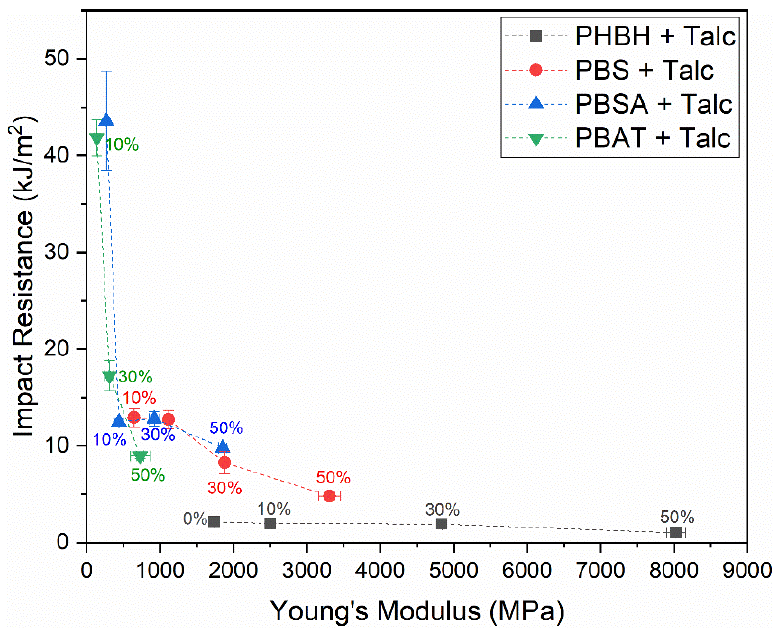
Figure 6. Relation between the Young’s modulus and notched impact resistance of talc-filled PBS, PBSA, PHBH, and PBAT composites.